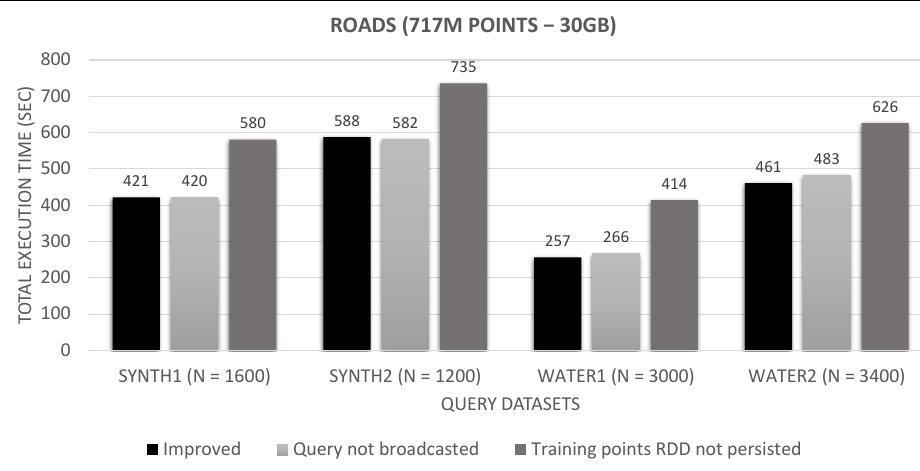
Figure 33. Large training dataset broadcast and persist